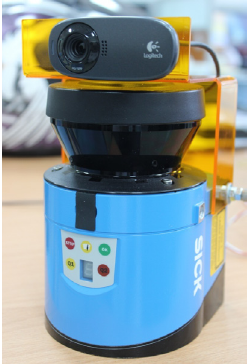
Fig. 1. An integrated multisensor system consists of a 2D laser scanner and a commercial